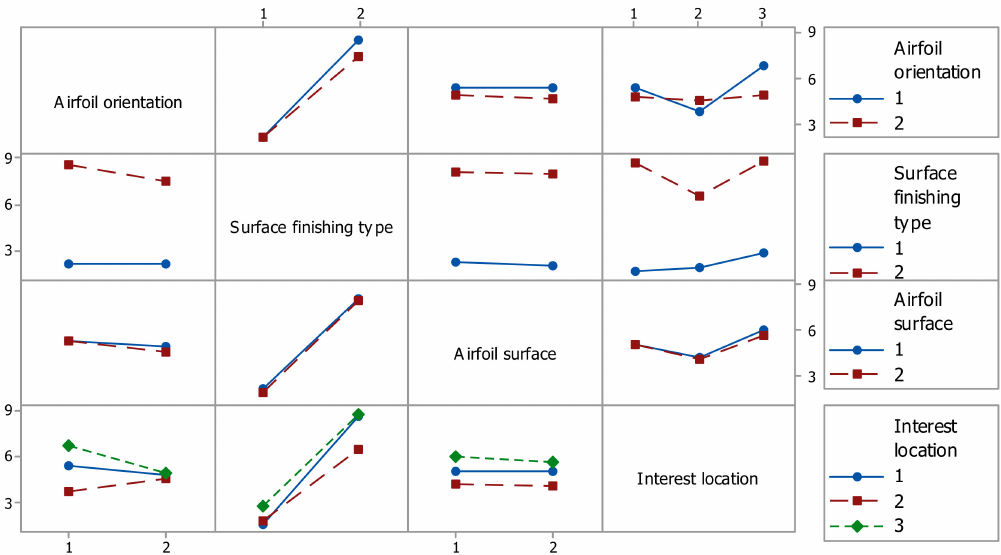
Figure 11. Interaction effects plot for surface roughness Ra.